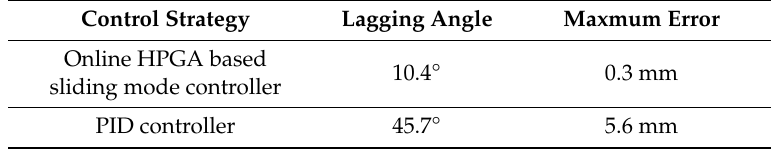
Table 4. Performance of the proposed method and PID controller with model uncertainties.